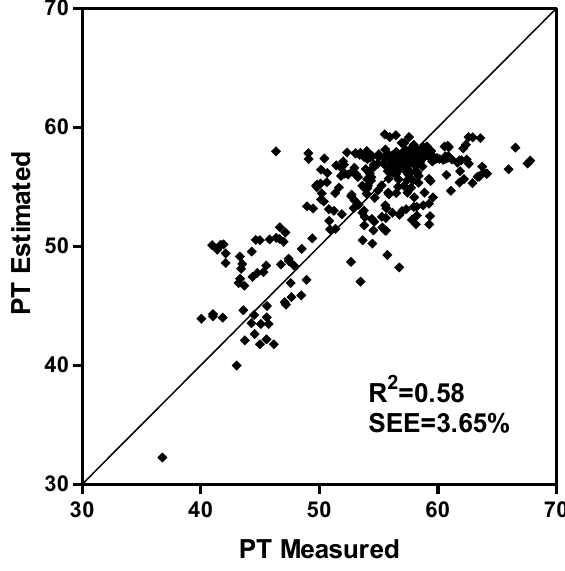
Figure 4. A comparison of measured and calculated percent transmission (PT; Equation (1)) of irradiance in the greenhouse used in the study of soybean flowering time at Ottawa,